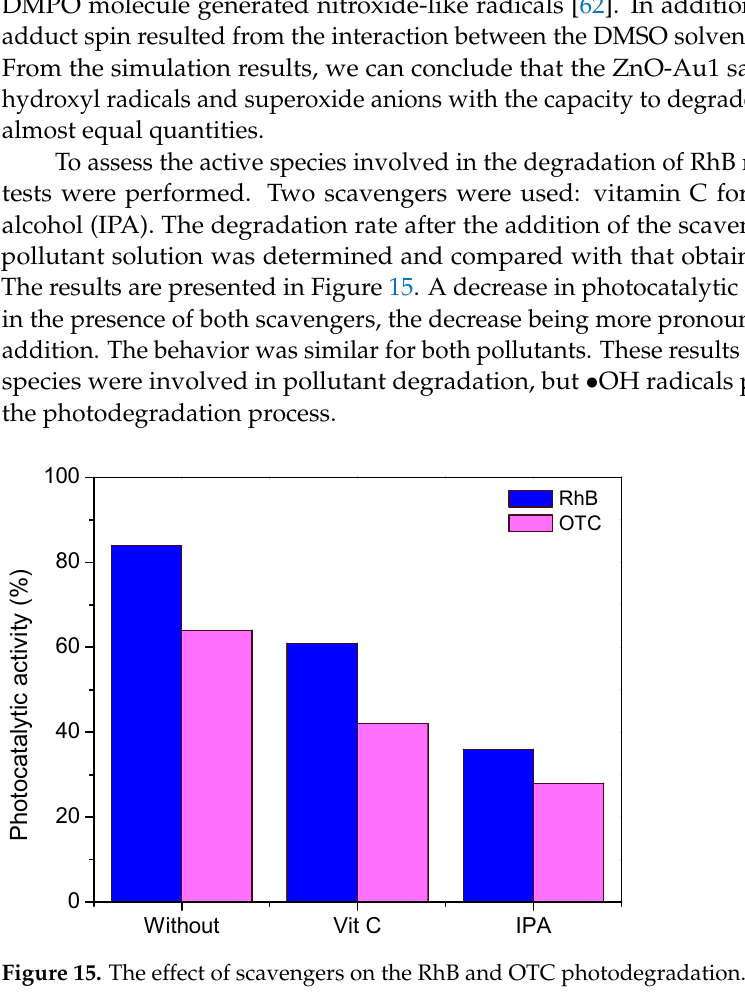
Figure 14. Experimental and simulated spectra of DMPO spin adducts generated by the ZnO-Au1 sample after 25 min of visible irradiation.